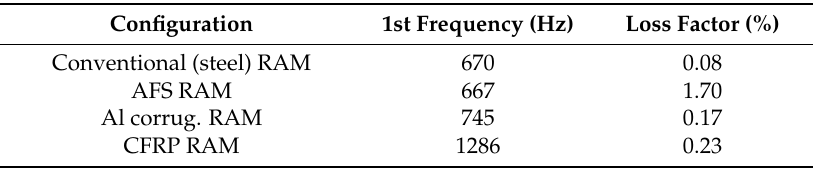
Table 7. The loss factor of the selected structures.